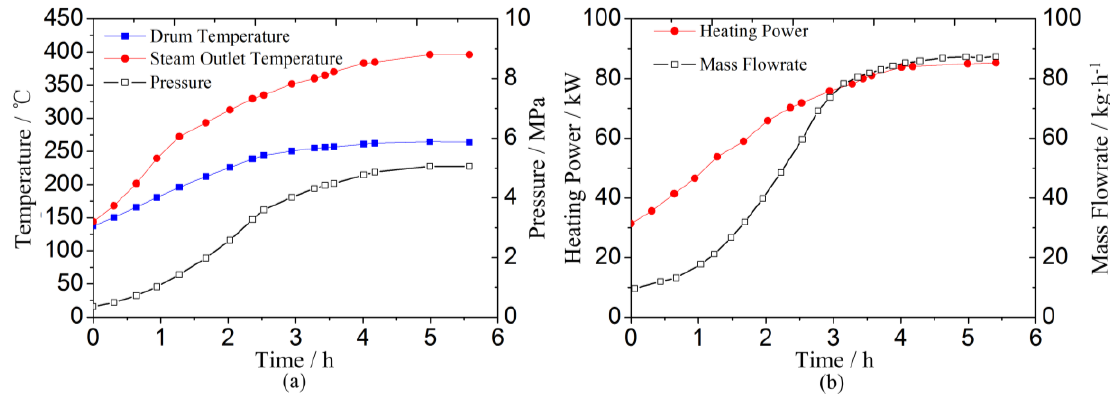
Figure 7. Start-up curves under operating pressure p = 5.1 MPa.